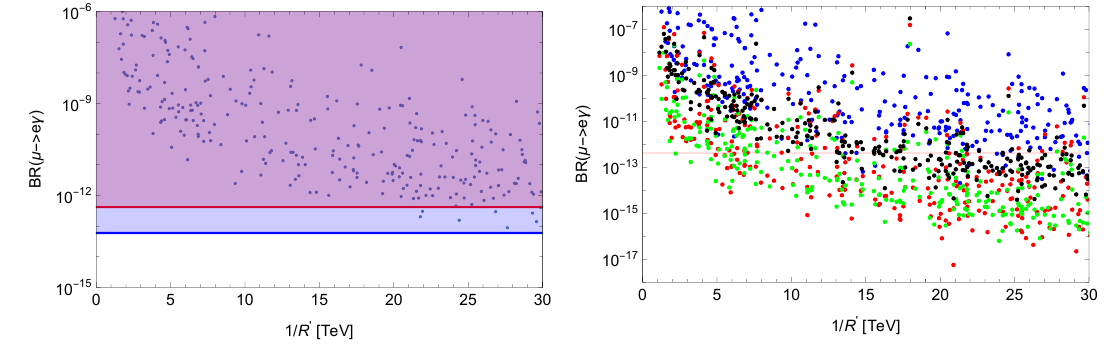
Figure 3 . Current (red) and future (blue) constraints on the µ → eγ decay, displayed together with the predictions of our scan (left), and relative size of the leptoquark (blue), Higgs (red), Z boson (green), and W boson (black) loop contributions (right), as a function of 1 /R 0 .